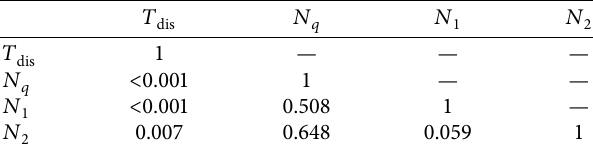
Table 2: P values of the